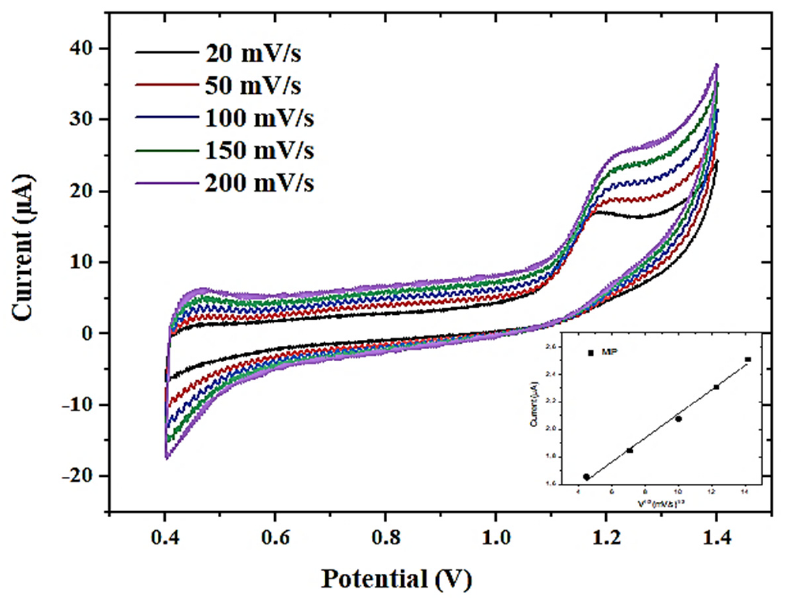
Figure 10. Effect of scan rate on the oxidation reaction of SDZ. Measuring conditions: 10 − 6 mol L − 1 SDZ in 0.1 mol L − 1 H 2 SO 4 (pH = 2).